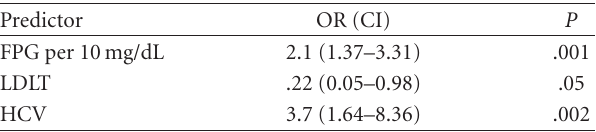
Table 5: Pretransplant predictors of NODAT in multivariate analysis.